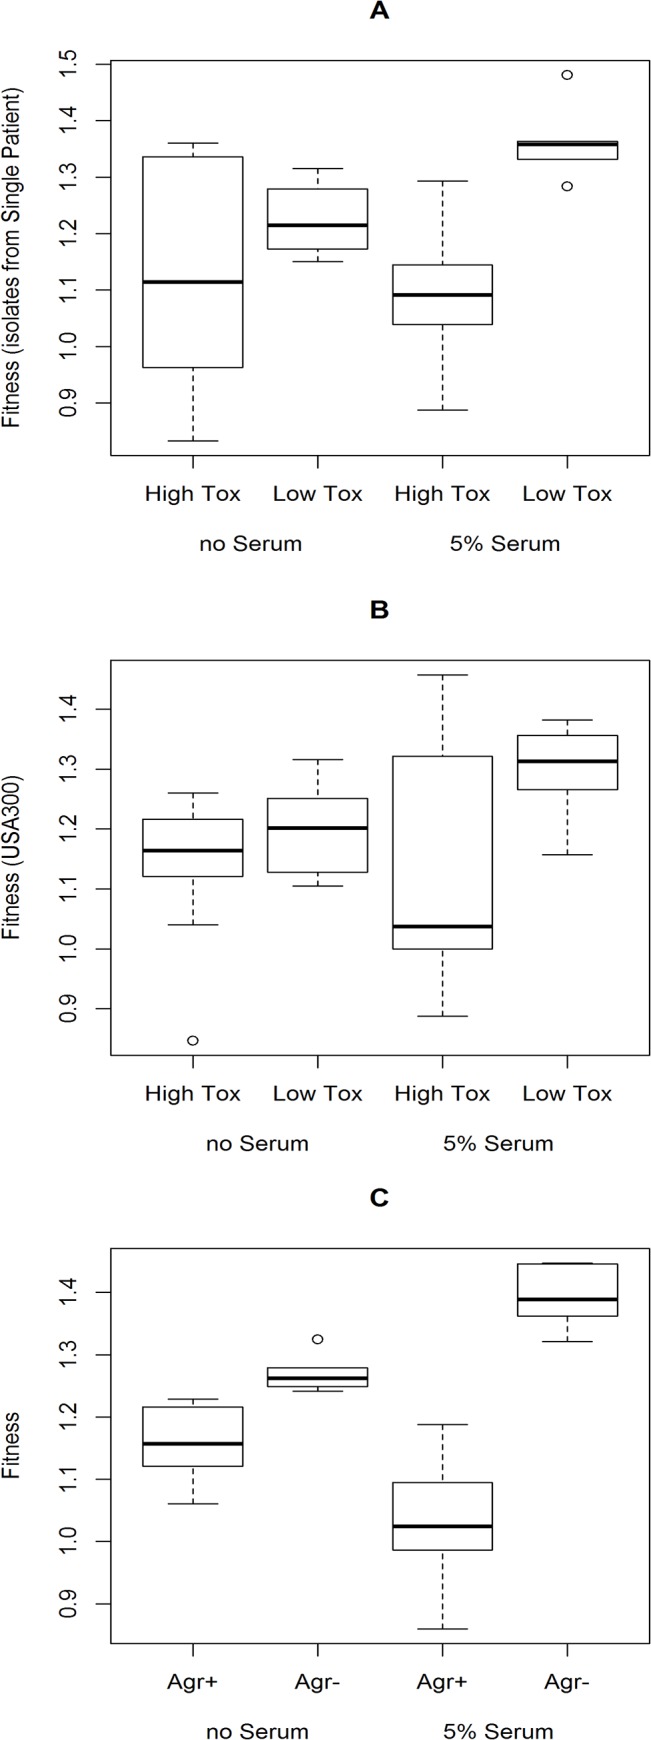
The highly toxic isolates are less fit than the low-toxicity isolates in the presence of human serum.We quantified the relative fitness of six high- and six low-toxicity isolates from the single patient collection (A), 10 high- and 10 low-toxicity isolates from the USA300 collection (B) and an Agr wild type and mutant isogenic pair (C) in BHI with and without 5% (vol/vol) human serum. The medians are presented as horizontal bars, with the boxes and whiskers showing the 1st and 3rd quartile and interquartile ranges. p-values are indicated in the text. To access this data, see S4 Data.